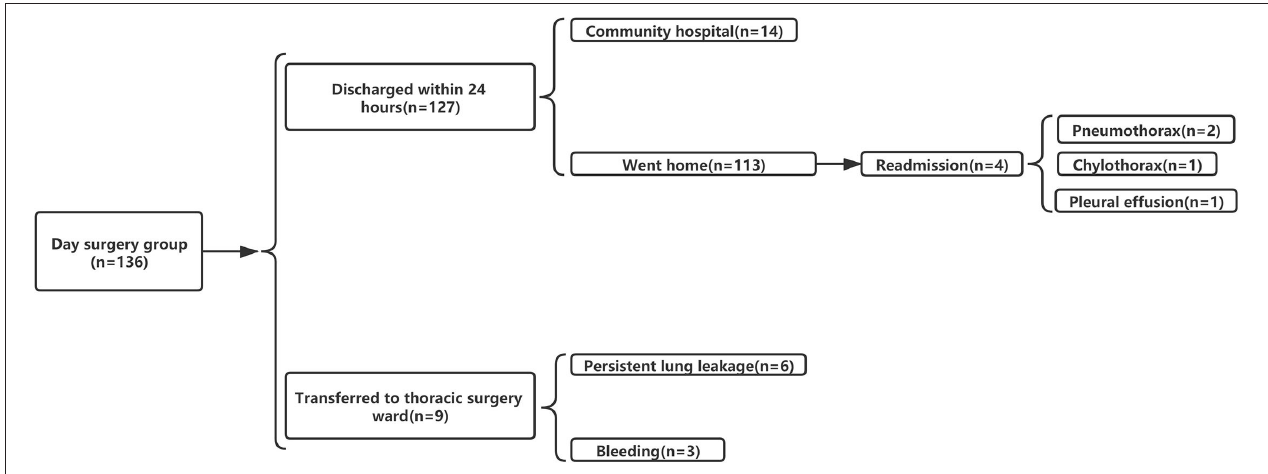
FIGURE 5 | Outcome in day surgery group (DSG).